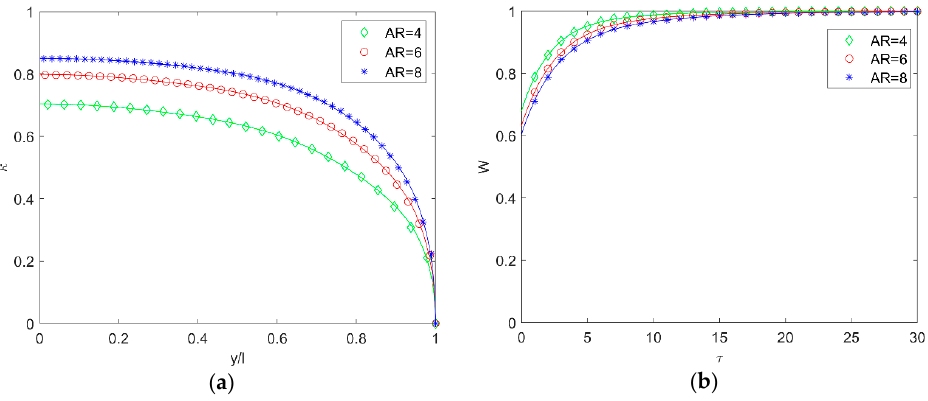
Figure 6. Lift decay ( a ) and build-up ( b ) for flat rectangular wings with different aspect ratio: symbols = numerical solution, lines = analytical approximation.